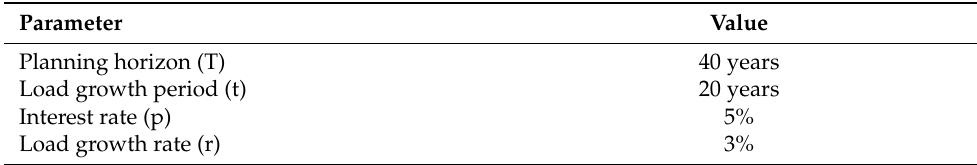
Table 2. Parameters for the cost evaluation of transformer and cables. Parameter